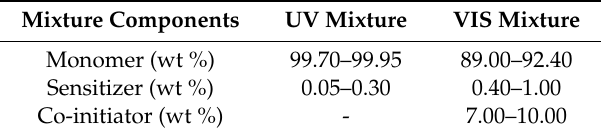
Table 1. The measured value of the tested mixtures’ refractive index